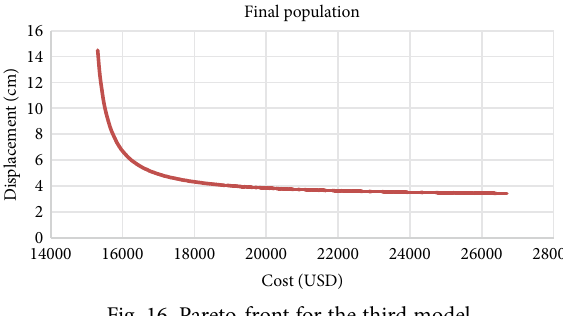
Fig. 16. Pareto-front for the third model